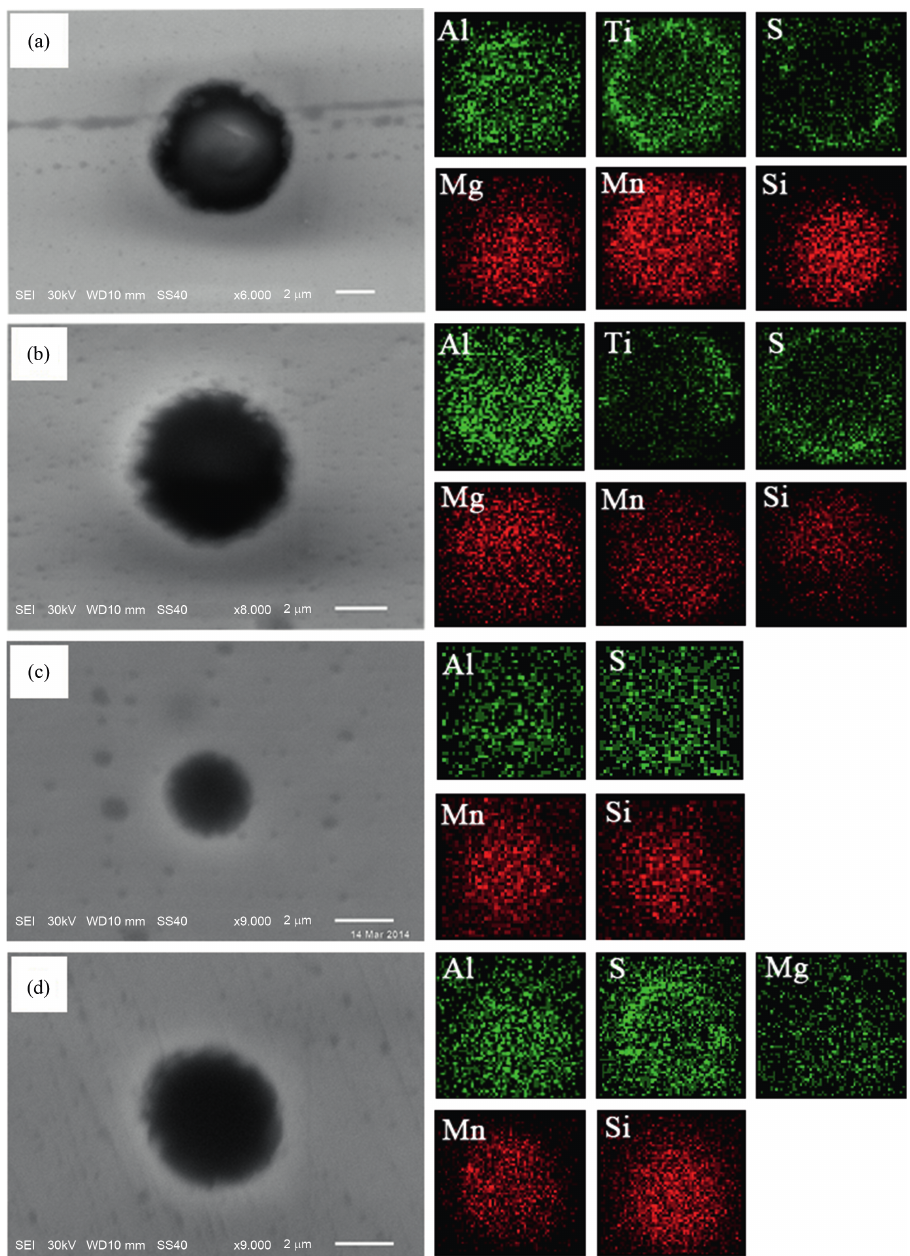
Figure 1: SEM micrographs and EDS mapping images of various elements for typical inclusion (a-b) for Ti – Mg treated sample, (c) for comparison sample A, (d) for comparison sample